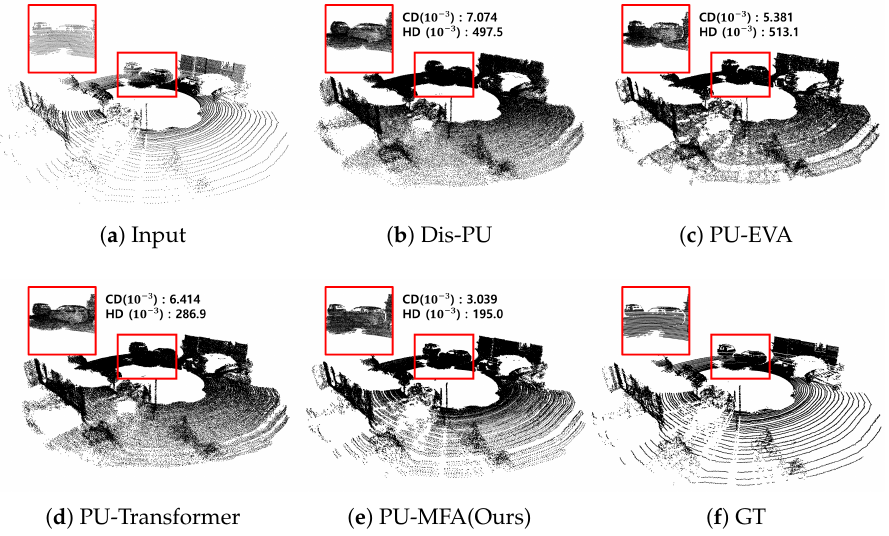
Figure 8. Visualization result of × 4 up-sampling of the KITTI dataset.